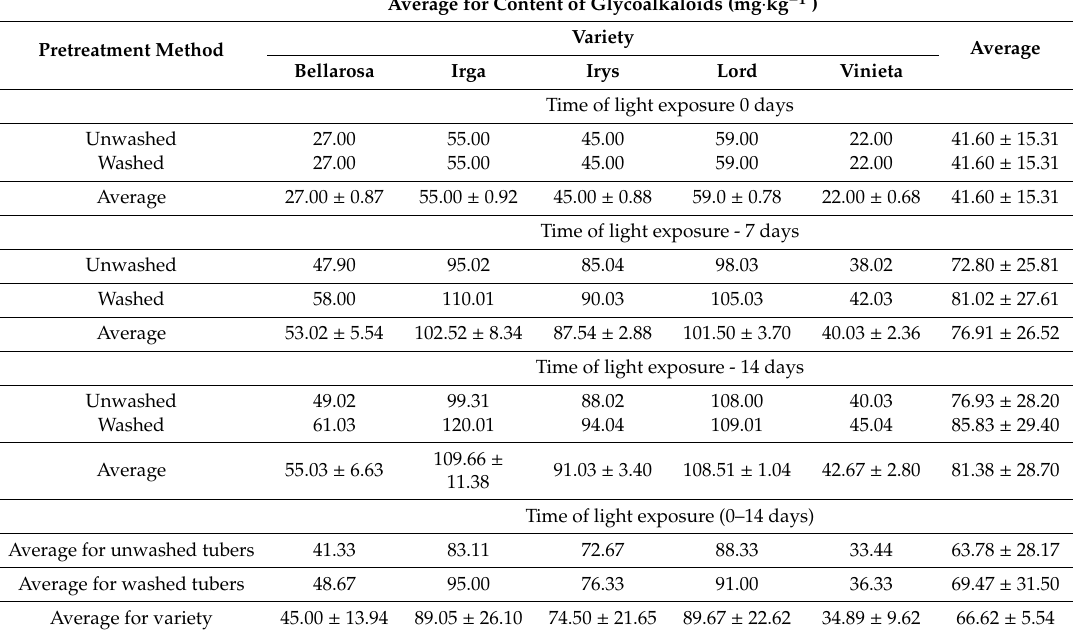
Table 1. Content of glycoalkaloids depending on the variety, pre-treatment and the time of exposure to light (mg · kg − 1 in fresch matter. Average for Content of Glycoalkaloids (mg · kg − 1